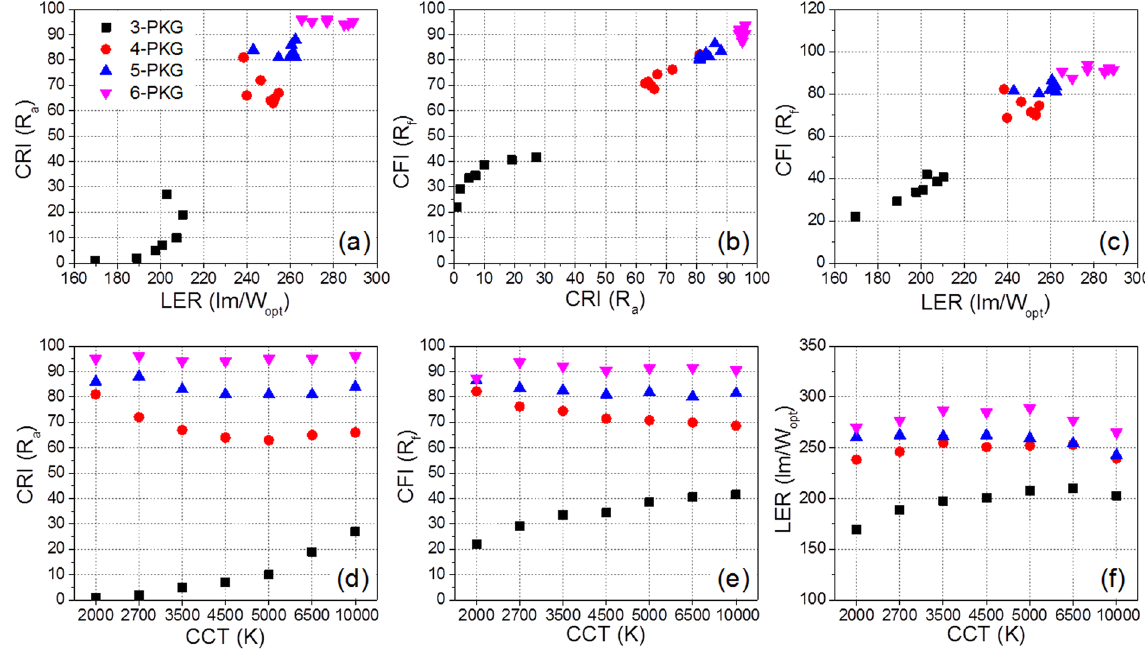
Figure 5. The relationships among ( a ) CRI-LER, ( b ) CFI-CRI, ( c ) CFI-LER, ( d ) CRI-CCT, ( e ) CFI-CCT, and ( f ) LER-CCT of the three- to six-package